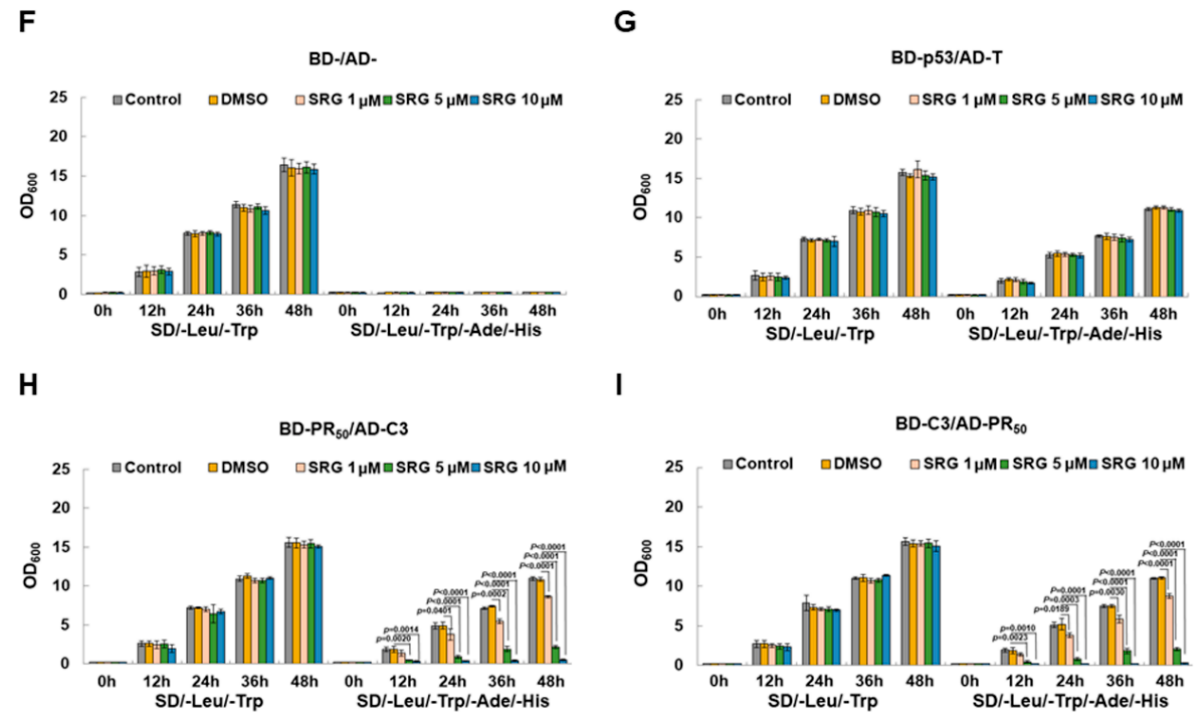
Figure 8. Syringin (SRG) blocked the interaction of PR 50 and C1QBP in the yeast two-hybrid-based growth assay. ( A ) Schematic drawing the principle of the yeast two-hybrid-based growth assay in identifying inhibitors of PR 50 –C1QBP interactions. ( B – E ) Log-phase cultures of diploid yeast cells containing plasmids encoding either Gal4 BD-/Gal4 AD-, Gal4 BD-p53/Gal4 AD-T, Gal4 BD- PR 50 /Gal4 AD-C1QBP (C3) or Gal4 BD-C1QBP (C3)/Gal4 AD- PR 50 were washed in water. We performed spot assays on non-selective (SD/-Leu/-Trp) and selective (SD/-Leu/-Trp/-Ade/-His) plates with serial dilutions of SRG and incubated them at 30 ◦ C for 3 days. ( F – I ) Overnight cultures of diploid yeast cells containing plasmids encoding either Gal4 BD-/Gal4 AD-, Gal4 BD-p53/Gal4 AD-T, Gal4 BD-PR 50 /Gal4 AD-C1QBP (C3) or Gal4 BD-C1QBP (C3)/Gal4 AD-PR 50 in a non-selective medium were washed in water and inoculated into non-selective and selective media at OD 600 = 0.2 in triplicates to implement the optical density measures every 12 h for 2